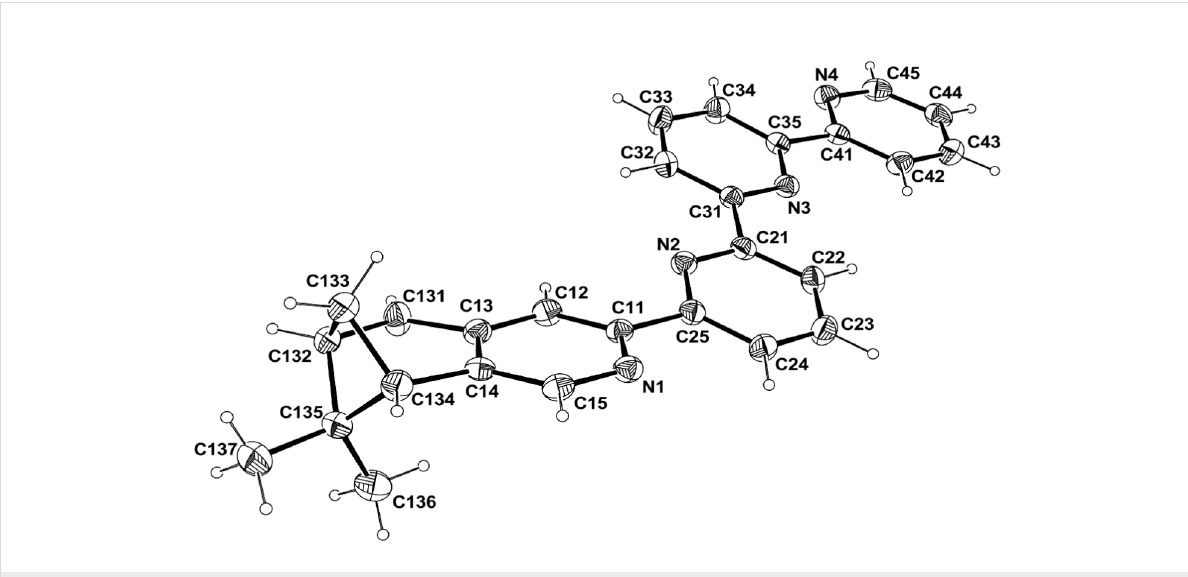
Figure 1: Molecular view of compound 8 with the atom labelling scheme. Ellipsoids are drawn at the 50% probability level. H atoms are represented as small circles of arbitrary radii.